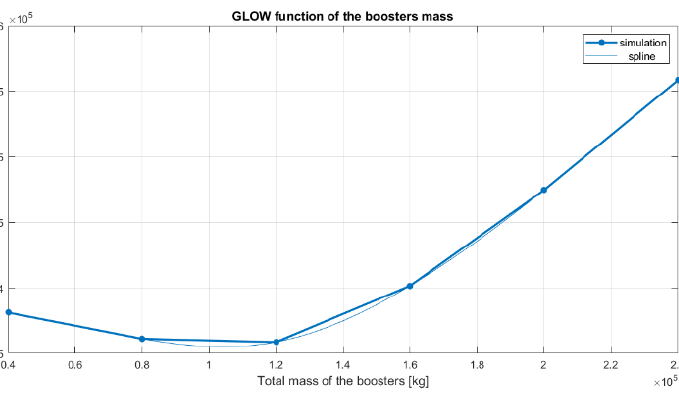
Figure 4. Optimization of the GLOW in function of the boosters’ mass. Table 5. Comparison between the result of the optimization and the real data for Mb = 160,000 kg. Simulation